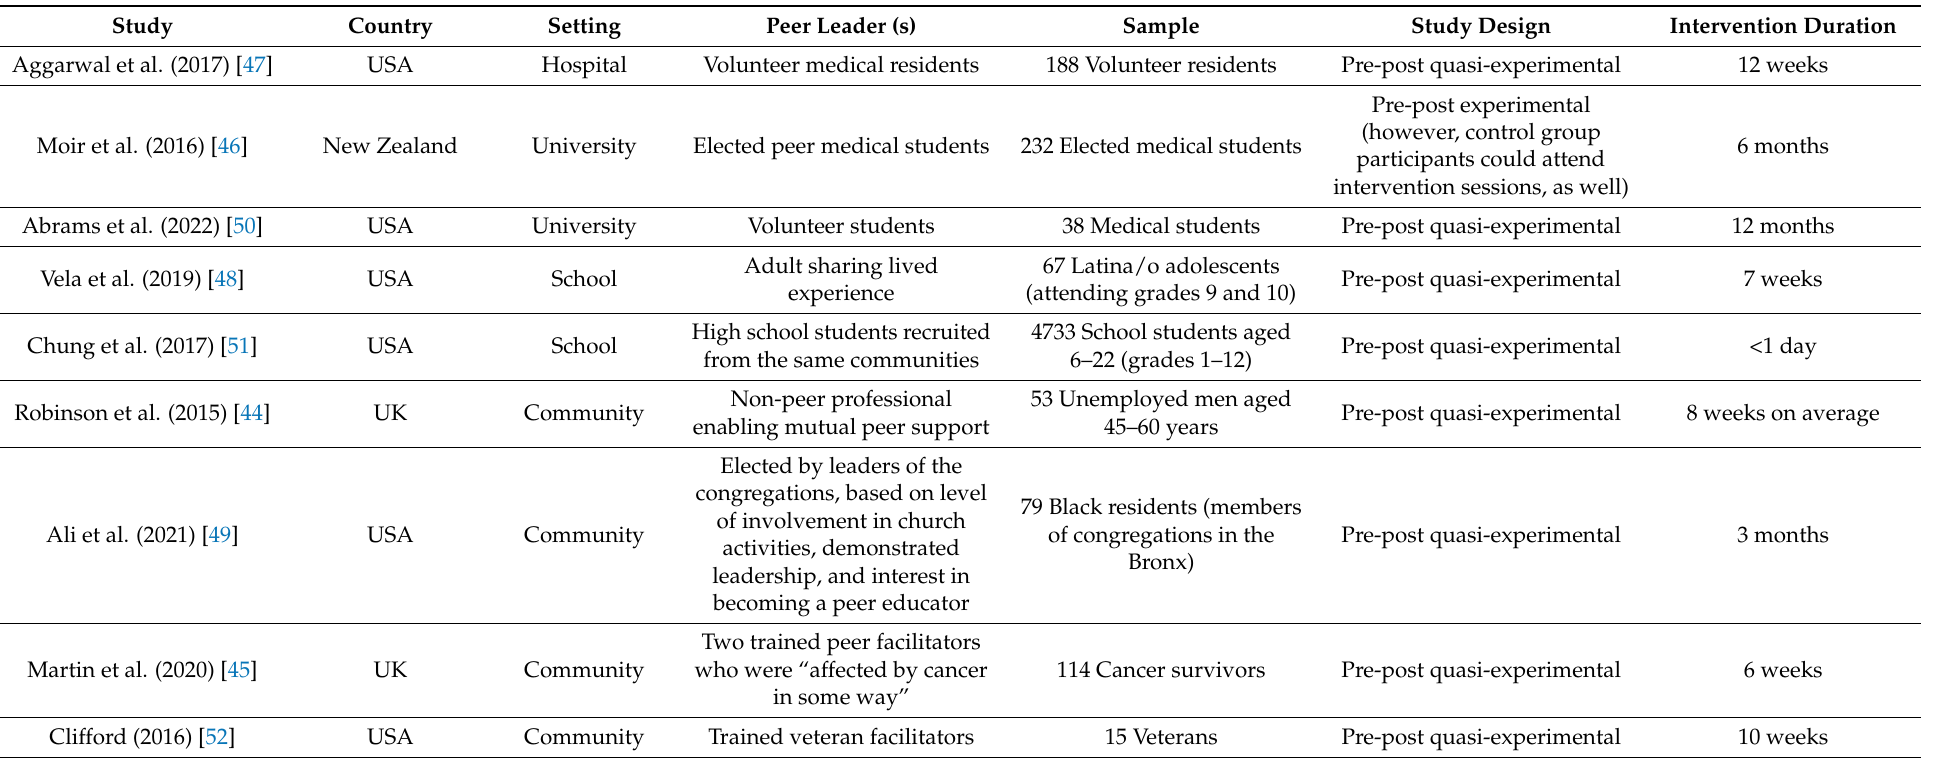
Table 1. Overview of relevant studies included in the